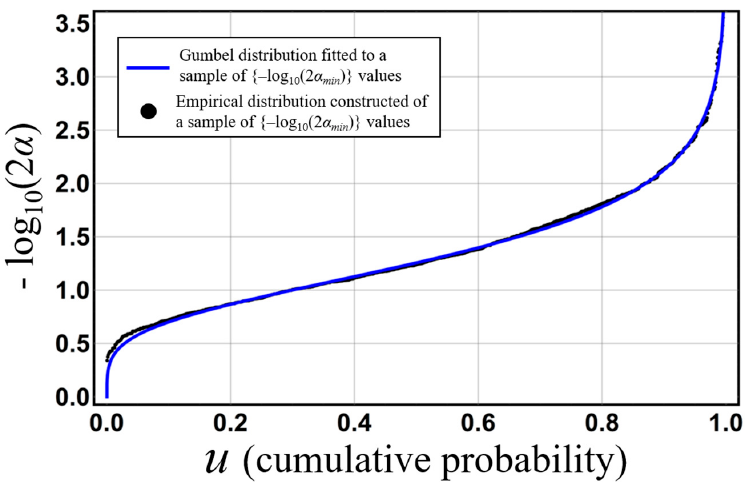
Figure 9. Empirical representing function constructed from a 1000-member set of − log 10 (2 α min ) values and a probability representing function of a Gumbel distribution fitted to a 1000-member set of − log 10 (2 α min ) values.